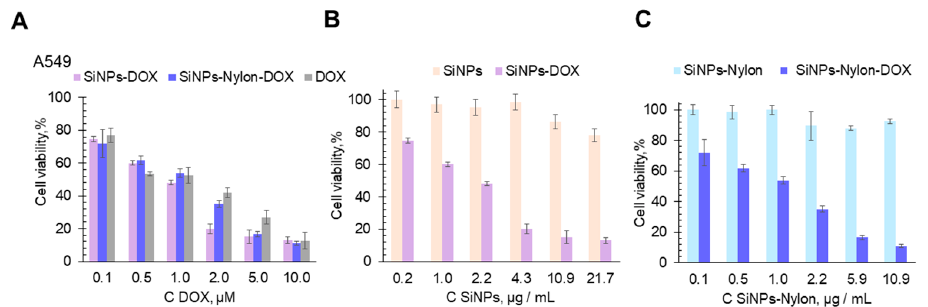
Figure 7. Cell viability assay (MTT test). A549 cell line was incubated for 48 h with SiNPs, SiNPs- Nylon, SiNPs-Nylon-DOX, SiNPs-DOX, and DOX. Cells treated with medium-supplemented PBS buffer instead of the nanoparticles’ solution were used as a 100% viability control. Cells were incubated with the same amount of free DOX or the DOX loaded on SiNPs ( A ) or with the same mass of SiNPs and SiNPs–DOX ( B ), SiNPs-Nylon and SiNPs-Nylon-DOX ( C ). The SiNPs-Nylon-DOX with a capacity of 493 μ g/mg (size 137 ± 2 nm by DLS) and SiNPs-DOX 258 μ g/mg (size 147 ± 5 nm by DLS) were used for cell viability studies. All values are given as the mean ± standard deviation (SD) values. All measurements were repeated not less than three times.